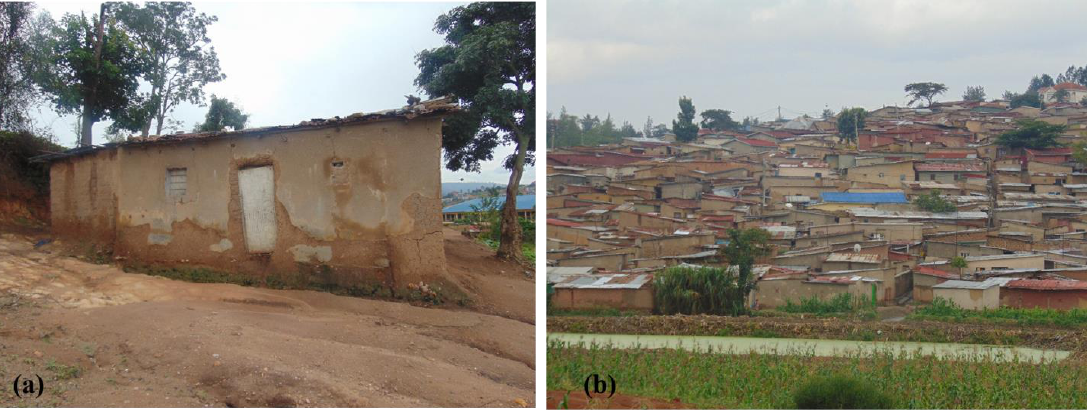
Figure 3. ( a ) Poor housing quality for the expropriated poor groups in Kangondo II; ( b ) Location of some of the expropriated residential buildings in the wetland area. Data Source: field observations.